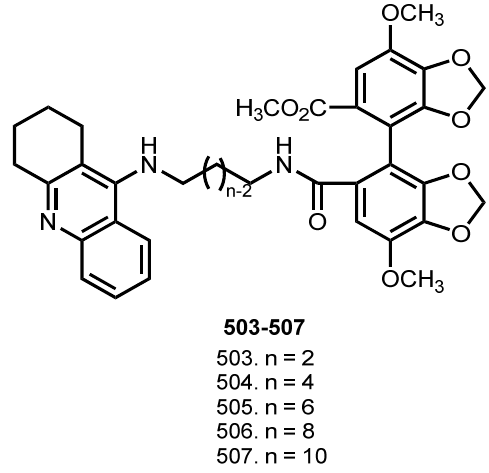
Figure 19. THA ‐ Bifendate hybrids 503 – 507 [86]. Figure 19. THA -Bifendate hybrids 503 – 507